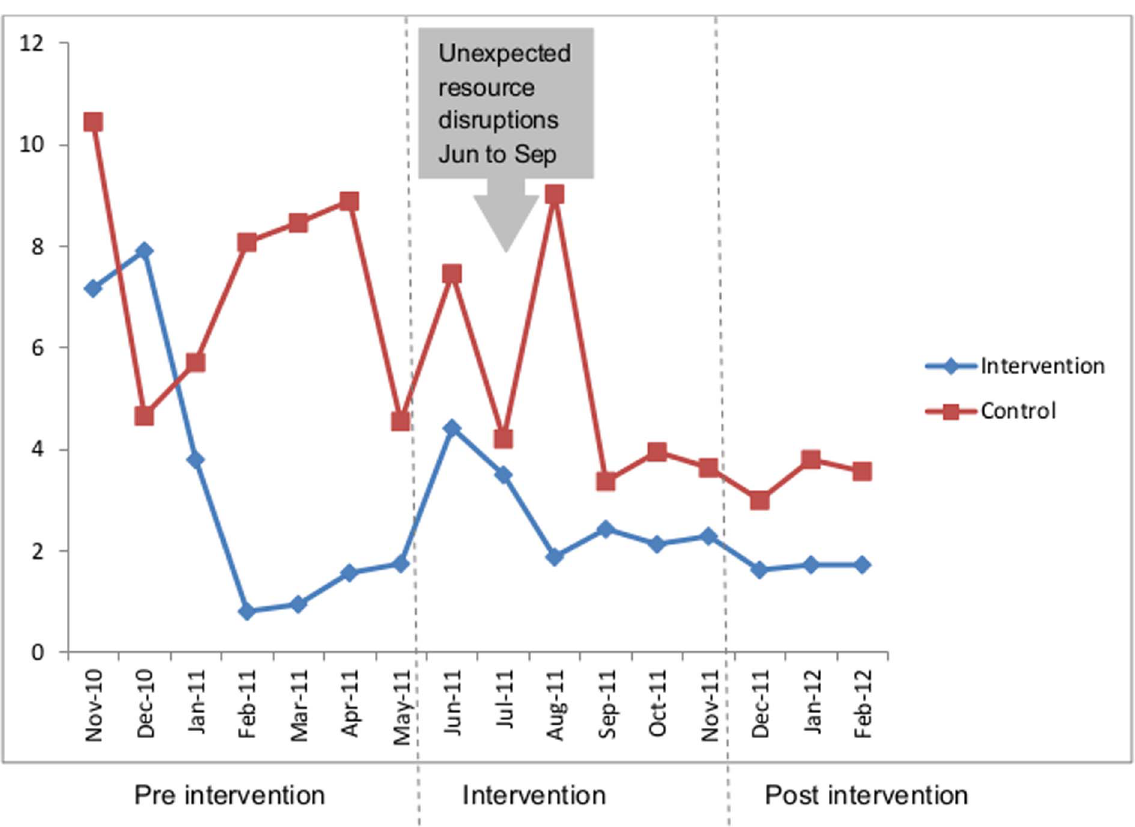
Figure 3. Percentage of women infected by month.